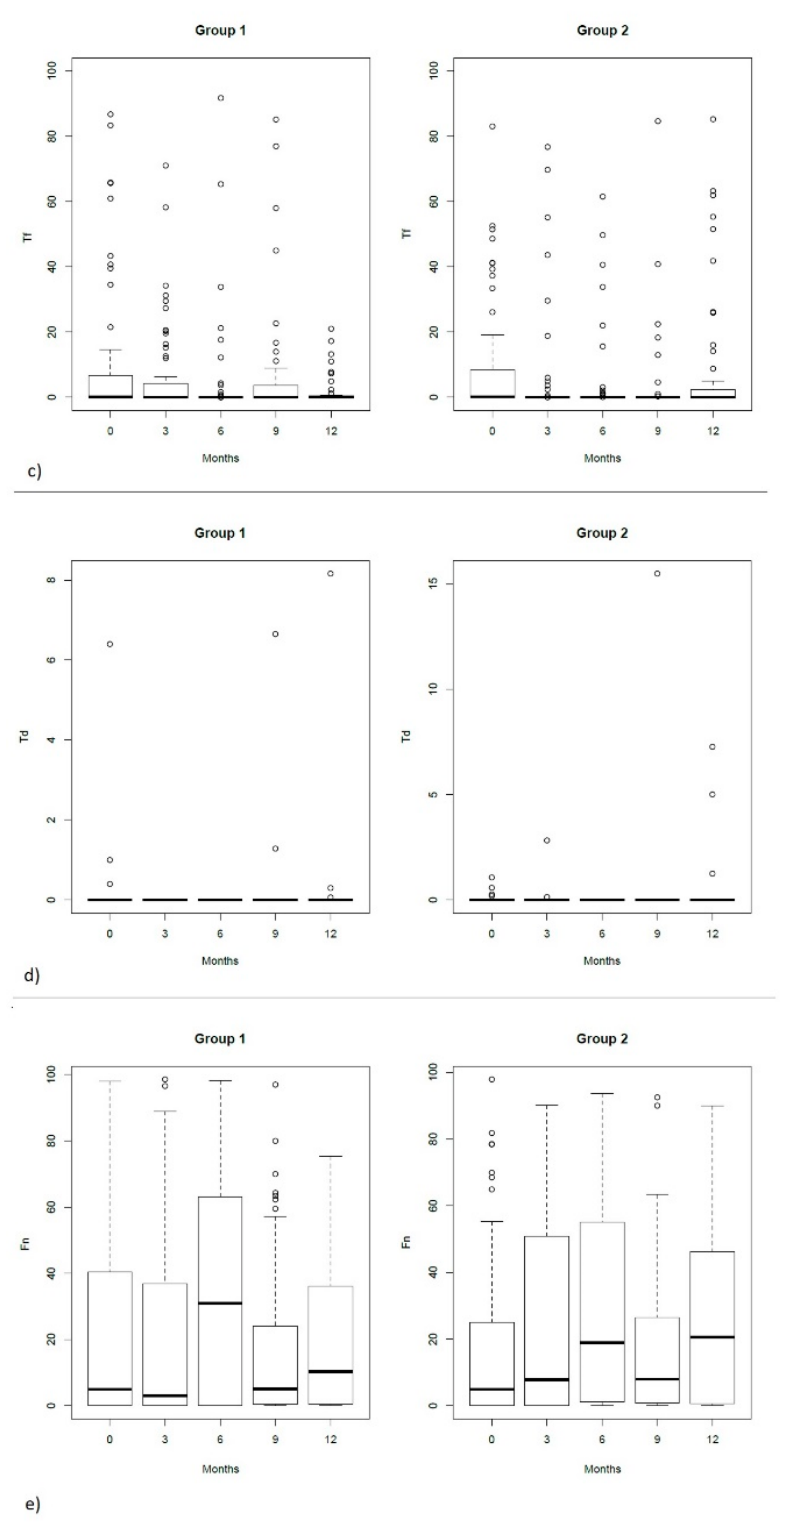
Figure 2. Box plot of the microbiological results. The median, interquartile range, minimum and maximum values (the square and the two extremities) and the outlier values (the circles) .